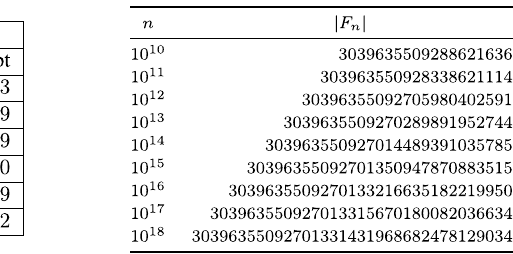
Figure 8. Evaluation results for C and Python implementations of algorithms C, D, and E. The run time curves plotted in ( a ) and the memory usage curves plotted in ( c ) are for the C code. The run time and memory usage plots for the Python code are shown in ( b ) and ( d ). The plots use the log scale for both axes and each point represents the average of 10 runs. The table in ( e ) gives the slopes and intercepts for lines that were fitted to the 10 10 and n 10 14 . The table in ( f ) shows the lengths of F twelve curves in ( a )–( d ) in the region between n n = = computed with algorithm E for several large values of n